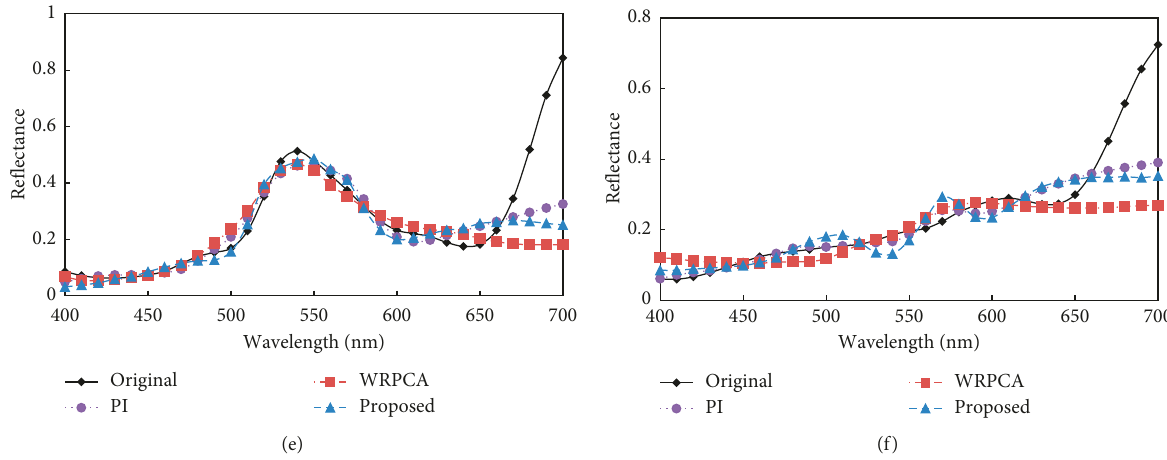
Figure 5: The measured spectral reflectance curve of two randomly selected samples from (a) and (b) the Munsell Chips, (c) and (d) the ColorChecker SG, and (e) and (f) the Vrhel dataset by using PI, WRPCA, and the proposed